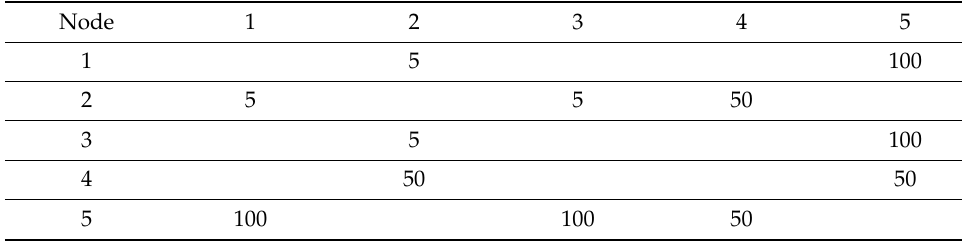
Table A1. The fuel cost of nodes (5 nodes and 5 vehicles example).